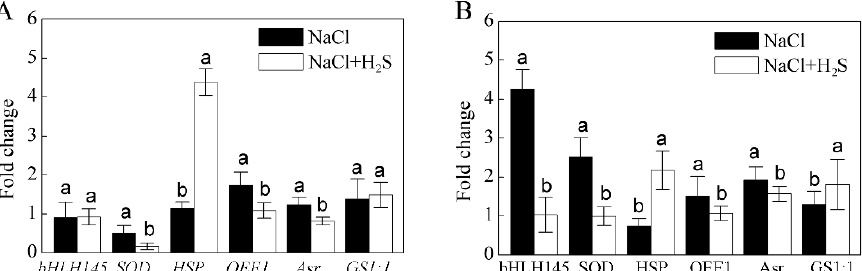
Figure 6. Comparison of expression changes at ( A ) mRNA and ( B ) protein levels for the selected six DEPs. They are basic helix-loop-helix 145 (bHLH 145), superoxide dismutase (SOD), heat-shock protein (HSP), oxygen-evolving enhancer protein 1 (OEE1), abscisic acid stress ripening protein (Asr), and glutamine synthetase 1;1 (GS1;1). The columns labeled with different letters are significantly different at p < 0.05 according to a Student’s t -test.